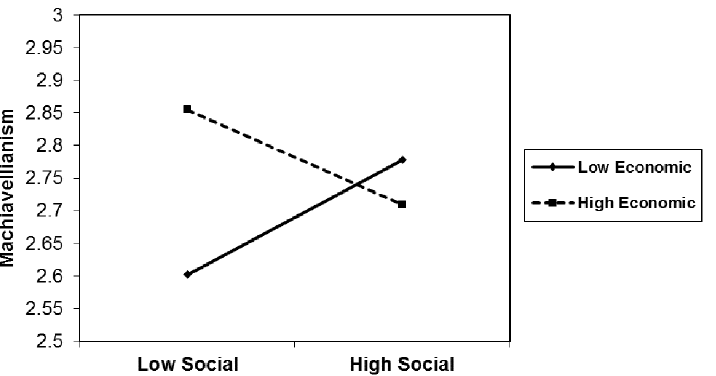
Figure 4. The Study 2 interaction between social and economic political ideology (measured via multi-item measures) in relation to Machiavellianism.